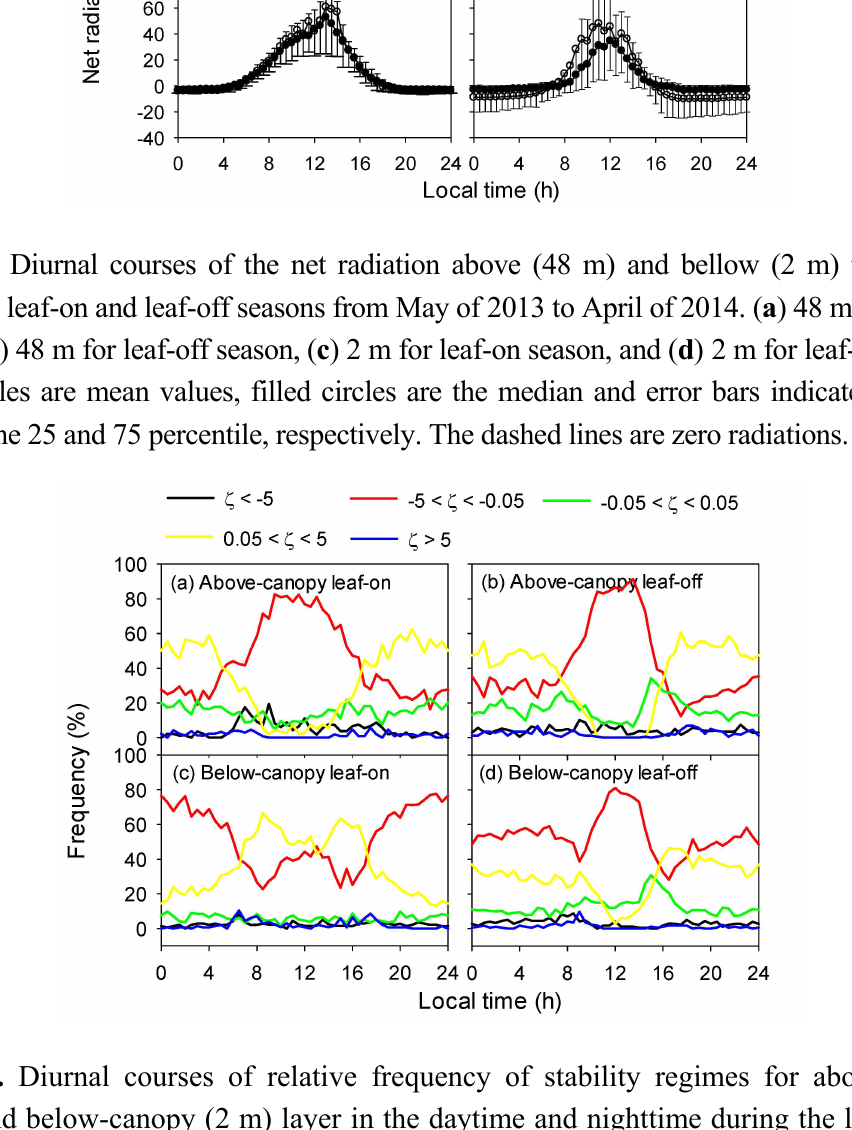
Figure 6. Diurnal courses of relative frequency of stability regimes for above-canopy (36 m) and below-canopy (2 m) layer in the daytime and nighttime during the leaf-on and leaf-off seasons of 2012. ( a ) 36 m for leaf-on season, ( b ) 36 m for leaf-off season, ( c ) 2 m for leaf-on season, and ( d ) 2 m for leaf-off